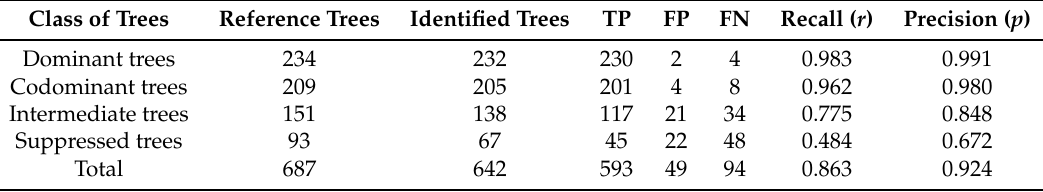
Table 3. Accuracy assessments for different tree classes in six test